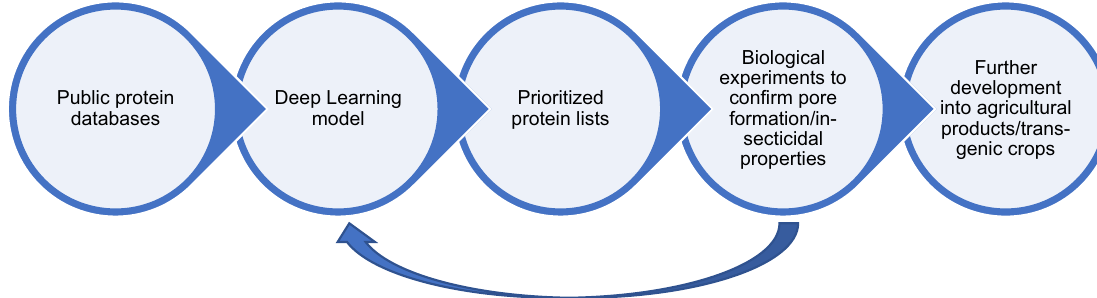
Figure 1. The usage of the proposed deep learning model in a workflow that could give rise to the next generation of agricultural products. In the proposed workflow, the deep learning model serves to shortlist proteins for further testing, thereby saving time and resources that need to be committed for experiments in laboratory and field settings. We can use our learnings from the experiments to further refine the